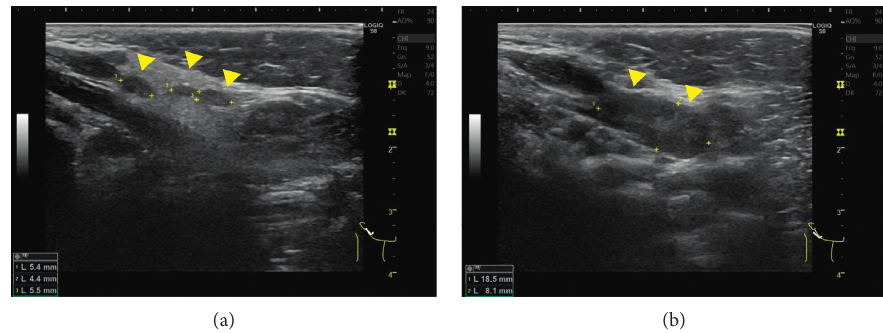
Figure 2: Cervical ultrasonography revealing mild reactive lymphadenopathy.